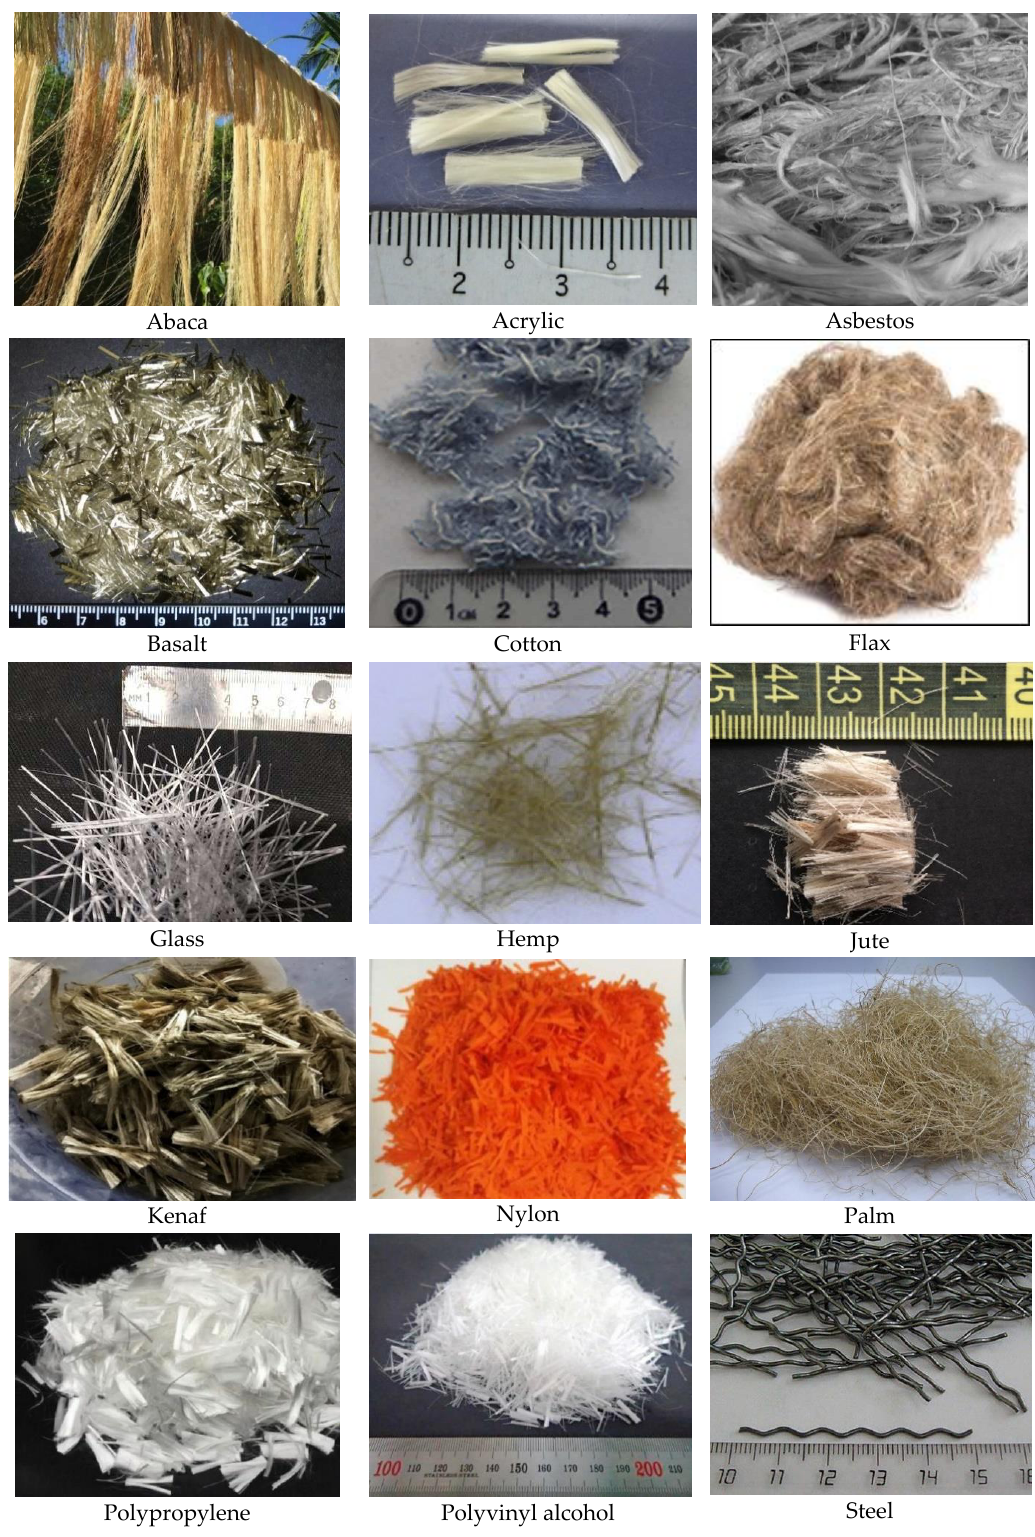
Figure 3. The appearance of some types of fibres.